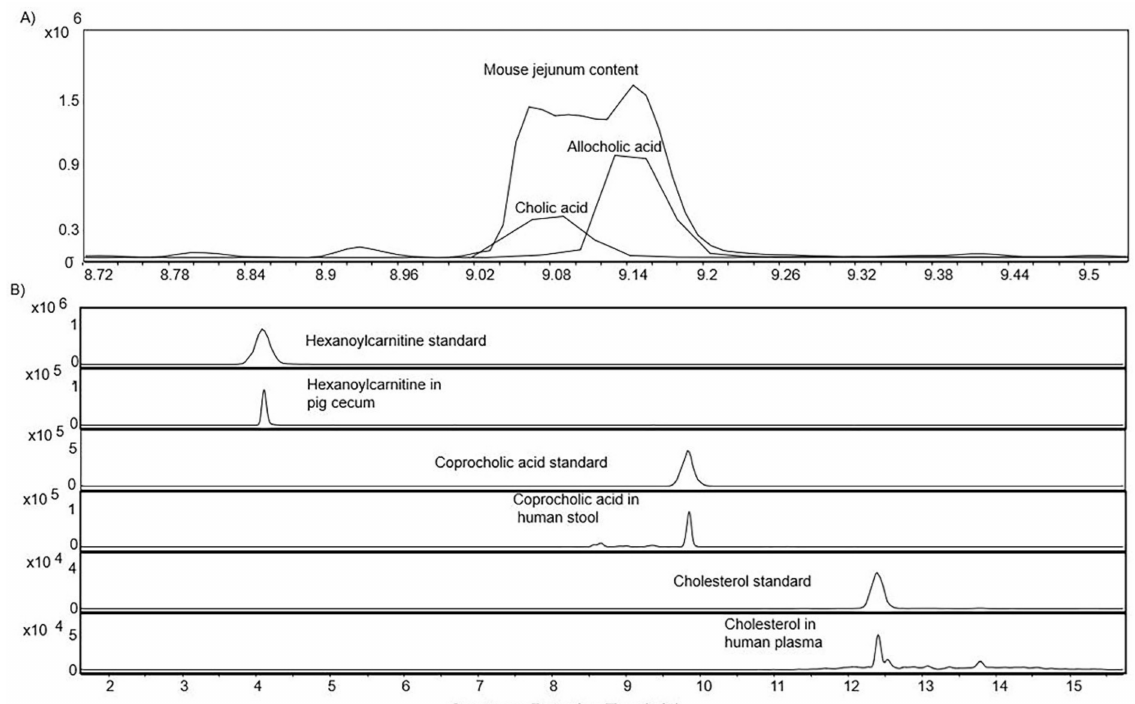
Figure 8. ( A ) Extracted ion chromatograms of the base peak spectra of bile acid isomer (cholic acid and allocholic acid) and their presence in mouse jejunum content in the positive ionization mode ( B ) Extracted ion chromatograms of the base peak spectra of a sterol, bile acid, and acylcarnitine standard, and their occurrence in the biological samples in the positive ionization mode demonstrating the absence of any confirmed case of matrix effect beyond 0.1